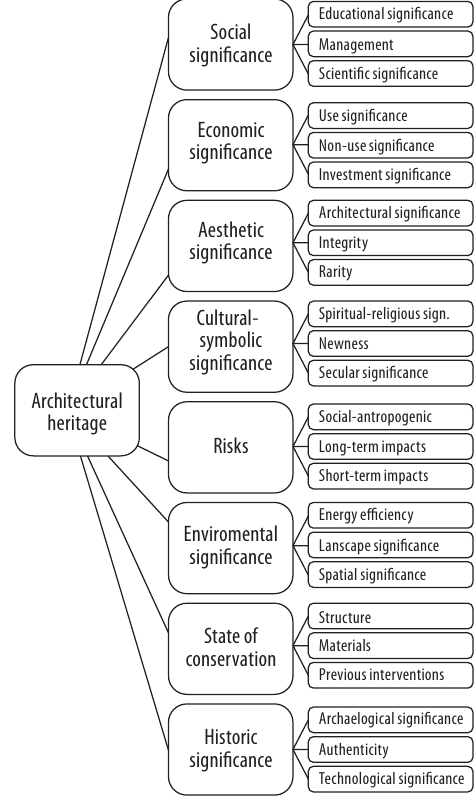
Fig. 2. Two-layered criteria tree with eight criteria, each with three sub-criteria, proposed for architectural heritage refurbishment priority